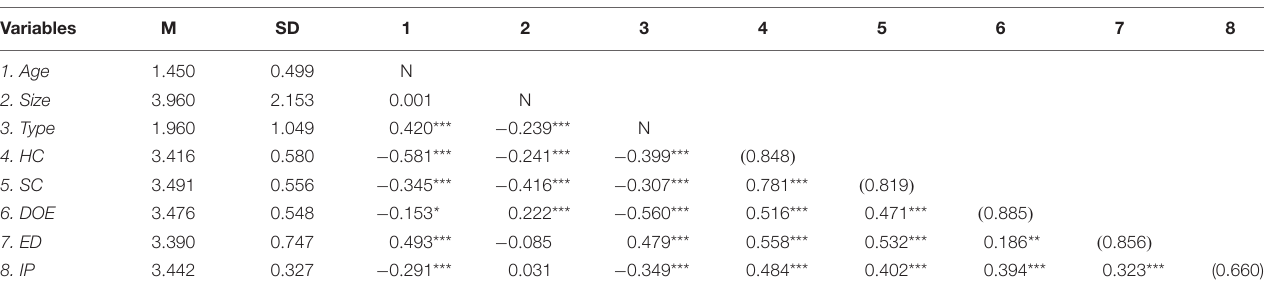
TABLE 2 | Mean, standard deviation, and